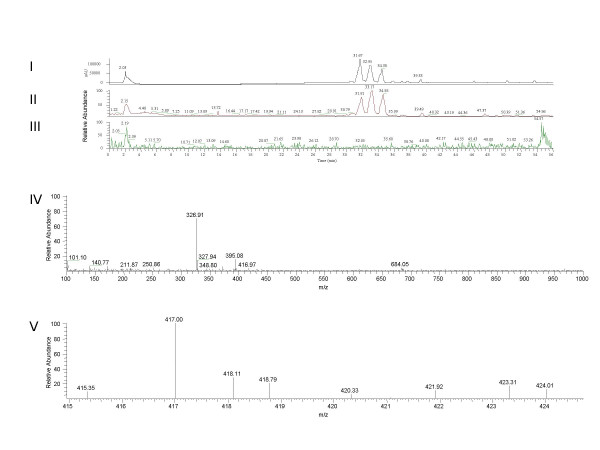
LC-UV-MS and LC-UV-MS/MS spectra of Ukrain®. Extracted ion chromatogram for m/z 417.2. I: LC-UV (290 nm) chromatogram; II: Total ion current (TIC) of mass range m/z 100 to 1000; III: LC-MS ion chromatogram of m/z 417.2 (extracted ion chromatogram); IV: Mass spectrum of peak with retention time 54.6 min; V: Zoom of mass range m/z 415 to 425 showing isotopic pattern of m/z 417.